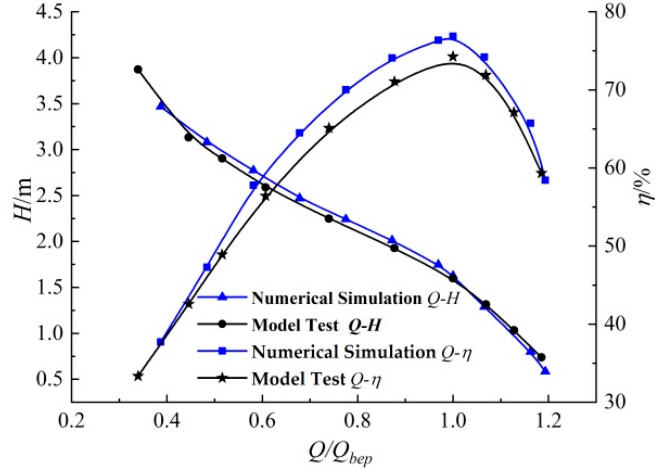
Figure 6. Comparison between numerical simulation and model test of axial-flow pump device.